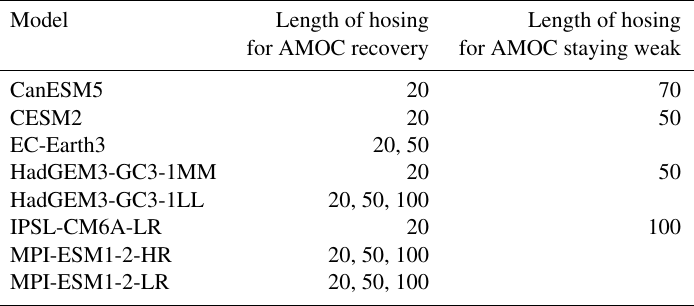
Table 4. Length of hosing, which determines whether the AMOC stays weak or recovers after 0.3Sv UH. States where the AMOC subse- quently recovers when hosing stops ( S R ) are listed in the middle column, and those states where the AMOC stays weak ( S W ) are listed in the right